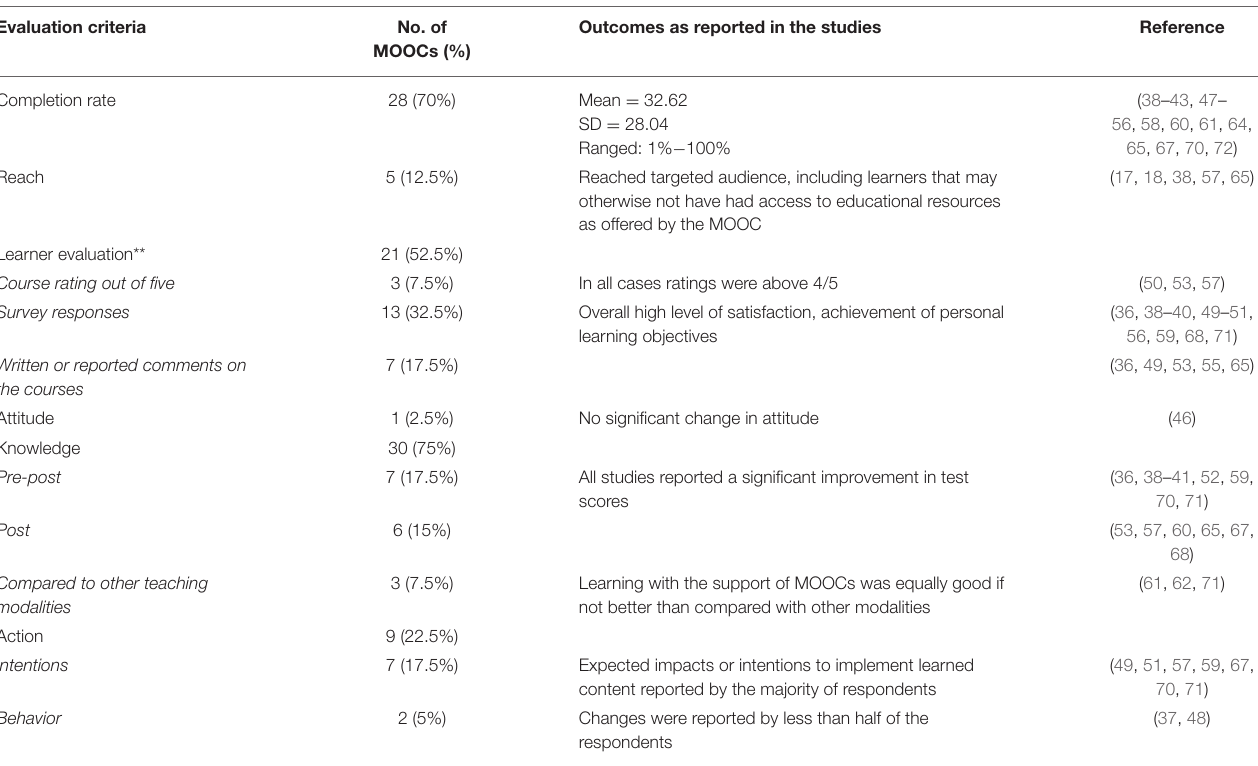
TABLE 7 | Six criteria used to define success of MOOCs identified in included studies *